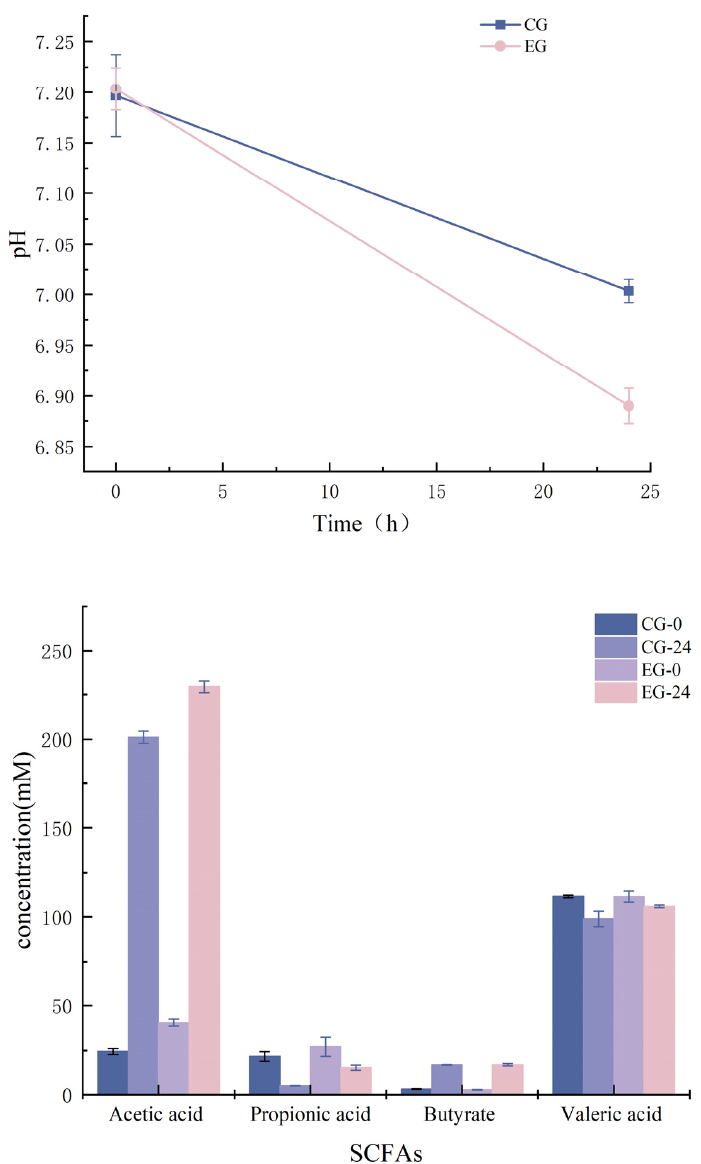
Figure 7. pH and SCFA concentration during in vitro fermentation ( p <